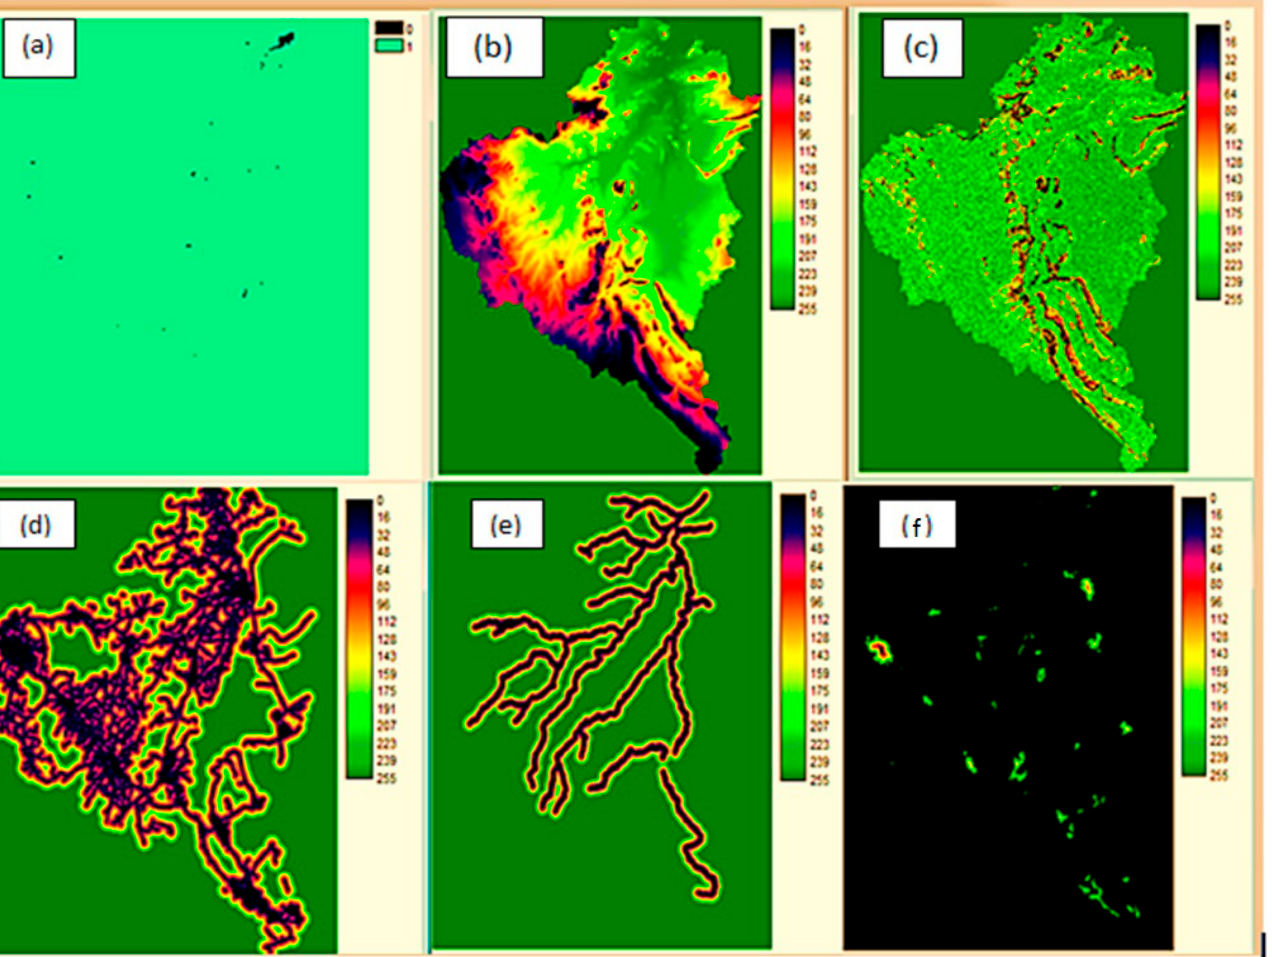
Figure 4. Factor and constraint maps—water body ( a ); elevation ( b ); slope ( c ); distance to roads ( d ); distance to rivers ( e ) distance to built-up areas ( f ). Table 2. Factors, constraints, membership functions and control points used for the preparation of suitability maps (modified from Gidey et al [61] and Hyandye and Martz [25]).